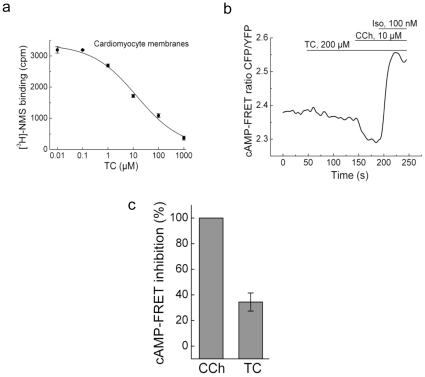
TC is a partial agonist of the M2 muscarinic receptor.(a) Specific binding of TC to muscarinic receptors in cardiomyocyte membranes. Competitive displacement of 3H-NMS with TC is shown (K
d values were 17.2±7.3 µmol/L, n = 3). (b) FRET-based cAMP measurements in NRCM upon stimulation with TC show its partial agonistic effect compared to the full agonist carbachol (CCh). Isoproterenol (Iso) was used a positive control to stimulate cAMP production. Representative experiment (n = 5), quantification is shown in (c).